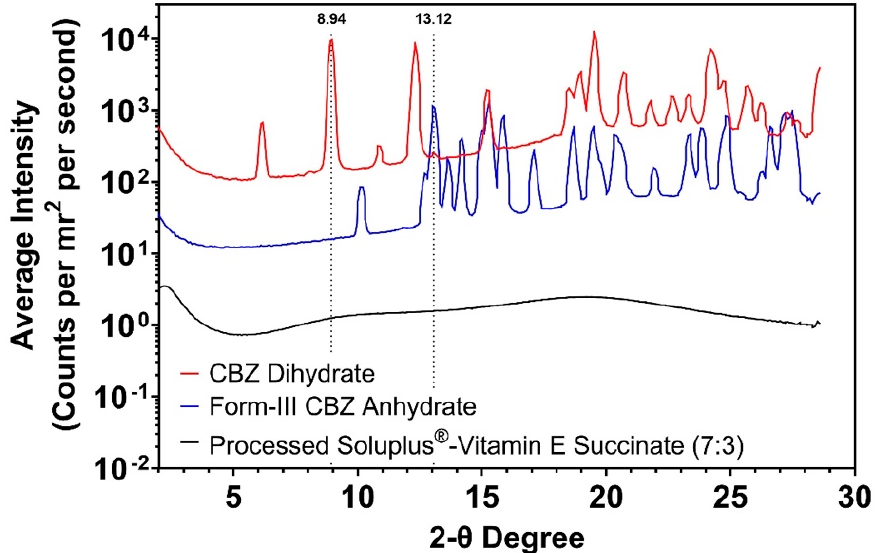
Figure 9. WAXS patterns of CBZ dihydrate (red), form-III CBZ anhydrate (blue), and processed Soluplus ® -Vitamin E succinate (black). Peak 8.94 two-theta degree and peak 13.12 two-theta degree correspond to CBZ dihydrate and form-III CBZ anhydrate, respectively.